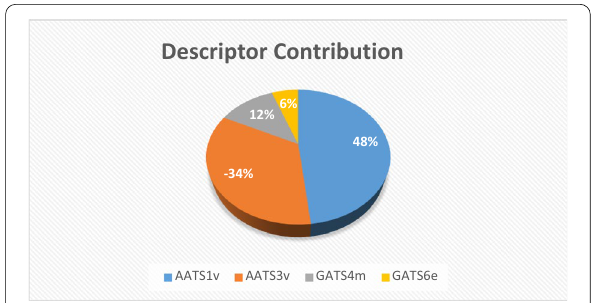
GPCR G protein-coupled receptor, ICM ion channel modulator, KI kinase inhibitor, NRL nuclear receptor ligand, PI protease Inhibitor, EI enzyme inhibitor, SA synthetic accessibility, GV Ghose violation, VV Veber violation, EV Egan violation, PA pain alert, MV Muegge violation